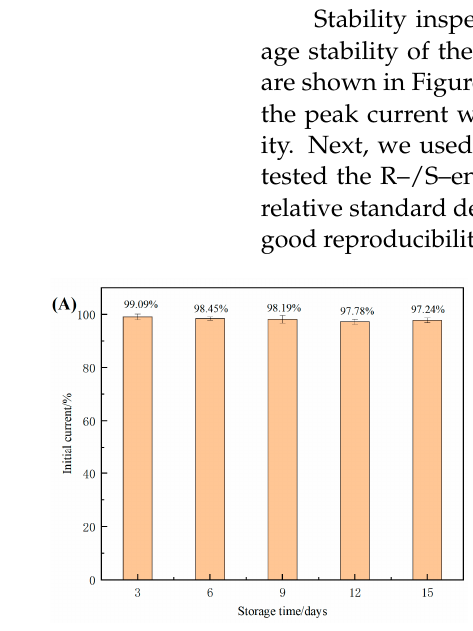
Figure 12. ( A ) The stability investigation and ( B ) the reproducibility investigation of the 3D–rGO– CS–BSA modi fi ed electrode in 0.1 M KCl containing 5 mM [Fe(CN) 6 ] 4 − /3 − solution.